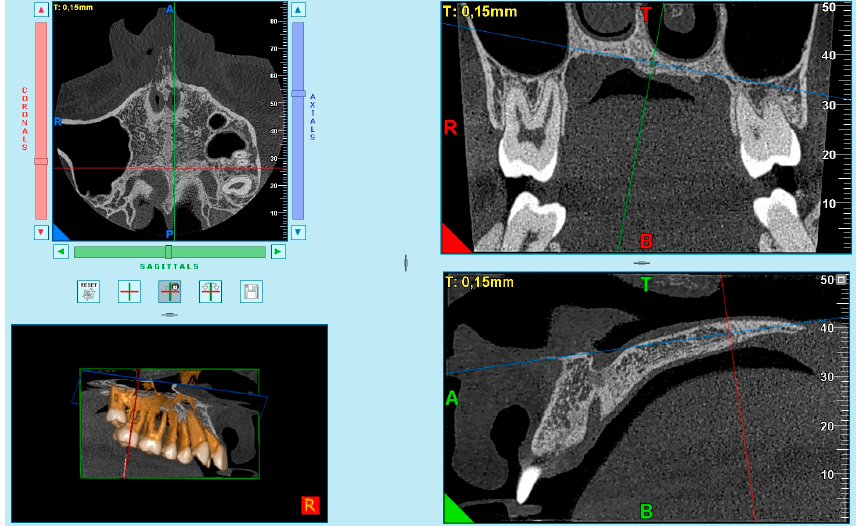
Figure 2. Posterior axial section—palatine processes of the maxillary bone .